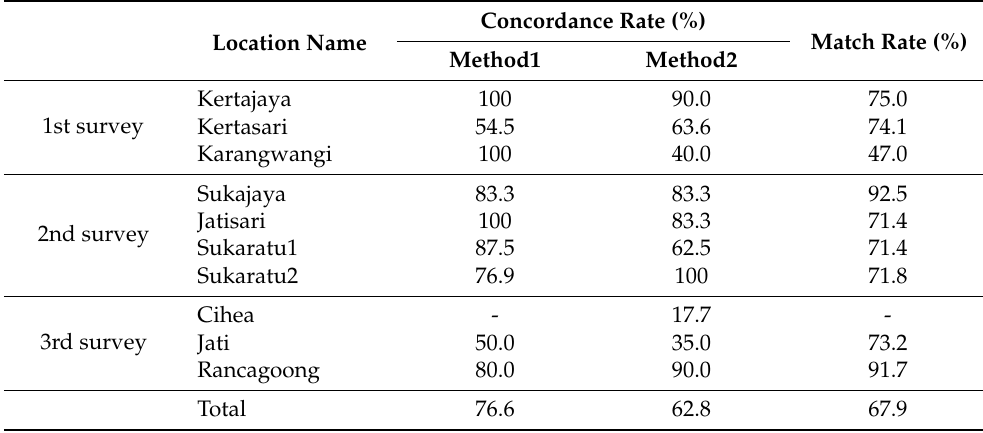
Table 7. Concordance rates between assessed DL and estimated DL for method1 and 2 and match rates of all estimated DLs between the two